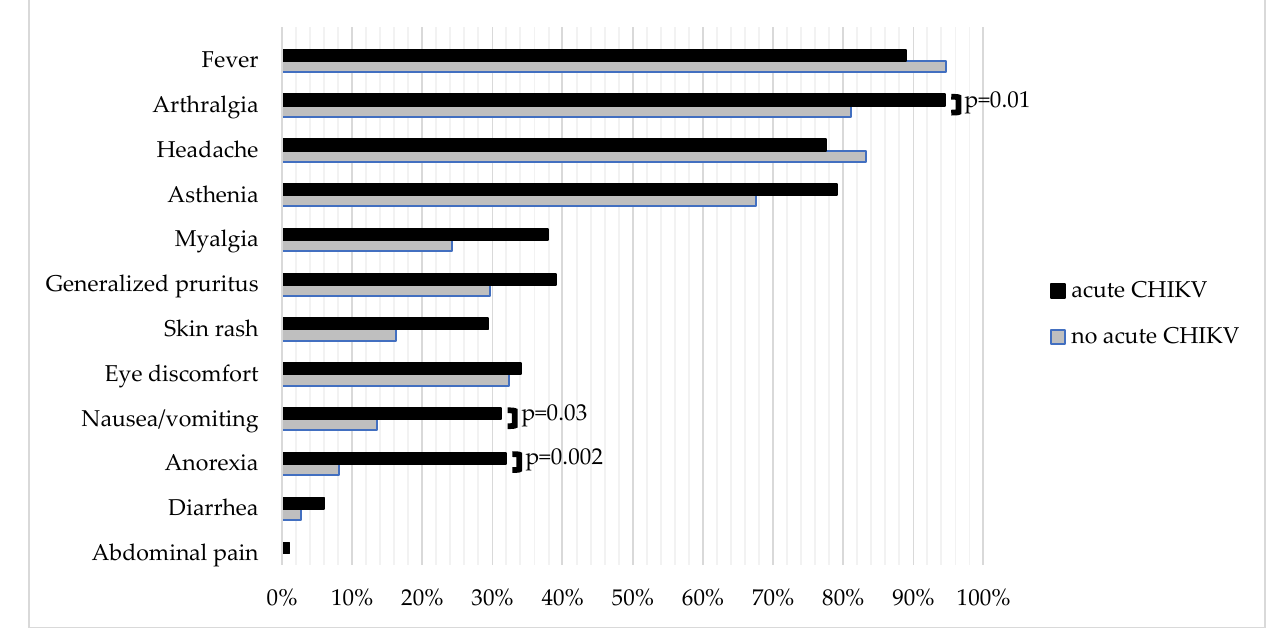
Figure 3. Comparison of frequency of clinical signs/symptoms between patients with acute CHIKV (N = 182) and without acute CHIKV (N = 37) infection. Note: Symptom data were missing for one patient with acute CHIKV infection. p -values if below 0.05.